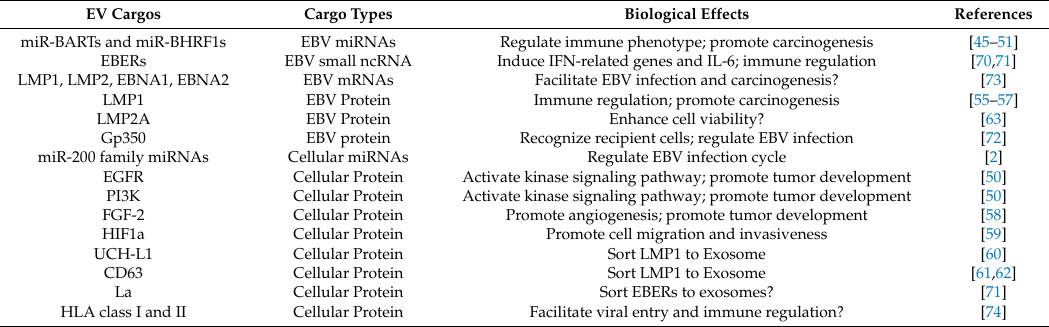
Table 1. Extracellular vesicle (EV) cargos and their roles in the regulation of Epstein-Barr virus (EBV) infection and